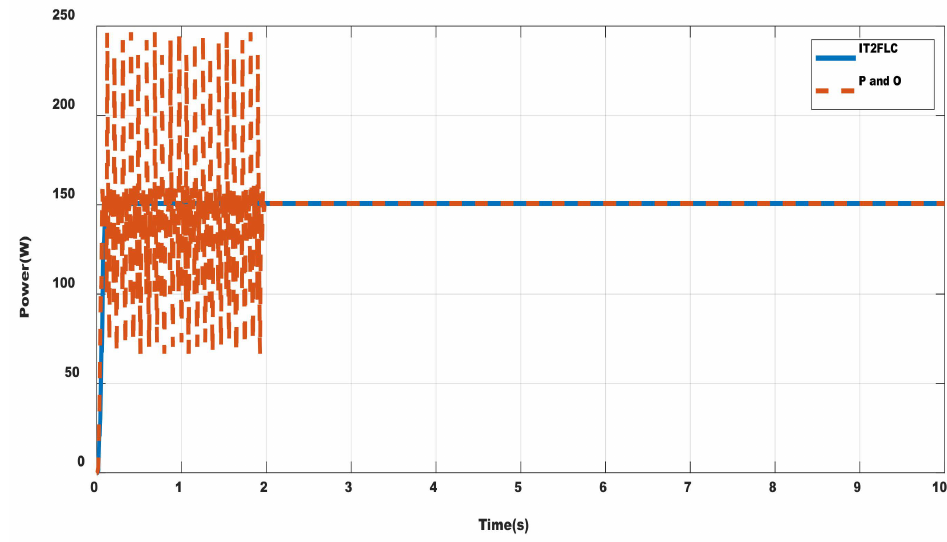
Figure 15. Power response for fixed step input at longer